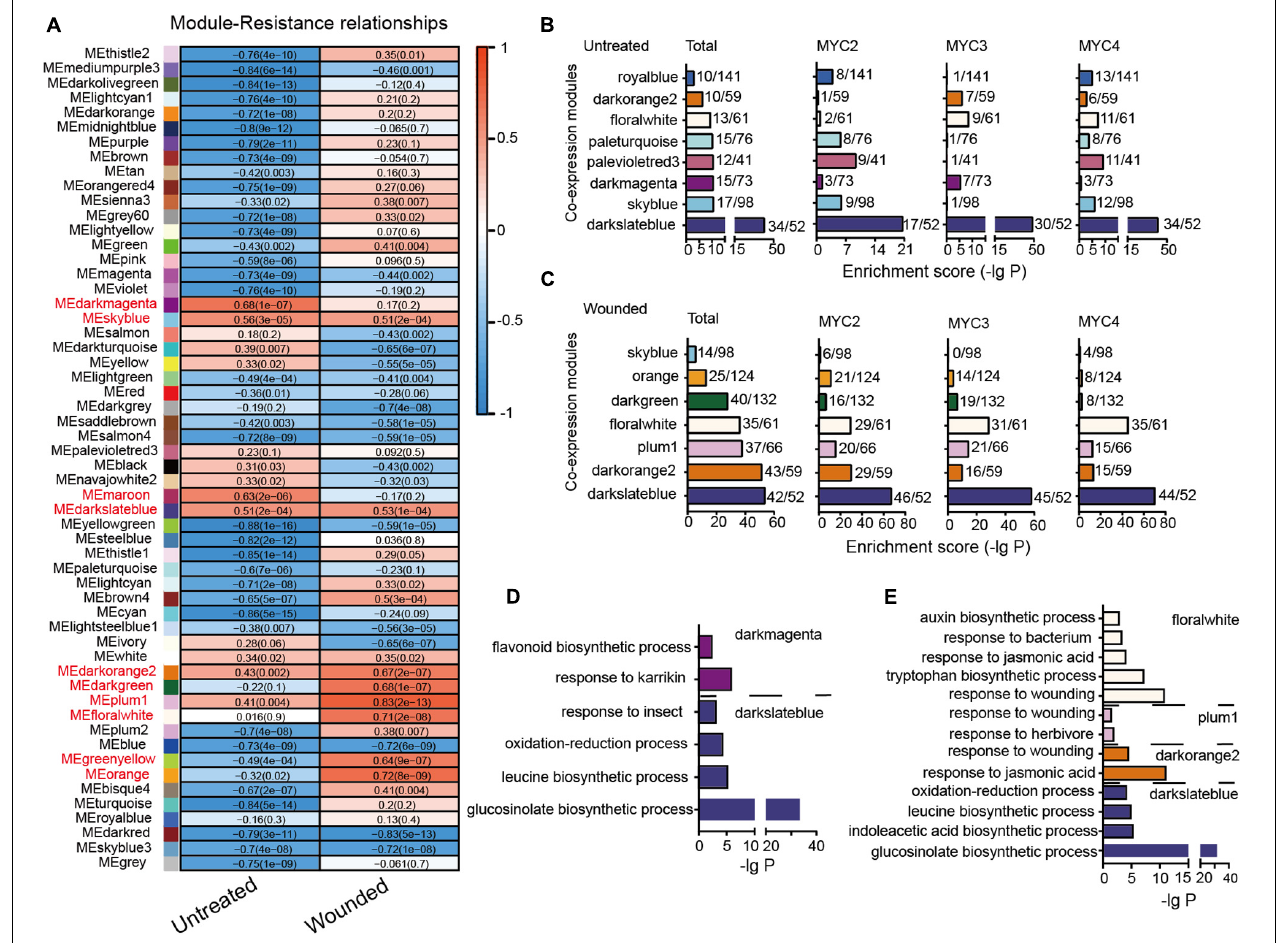
FIGURE 4 | Module classification based on gene co-expression. (A) Correlation of the module eigengenes with cotton bollworm resistance. Red to blue stands for positive to negative correlations between the module eigengenes and the plant resistance to cotton bollworm. The numbers represent correlation coefficients; and the numbers in brackets stand for P -value. (B,C) MYC2-, MYC3-, and MYC4-affected genes of the untreated (B) and wounded (C) plants are enriched in the indicated modules. The a/b values above the bars indicate gene numbers affected by all the three MYCs (Total) or the indicated MYC (a) and gene numbers of the corresponding module (b). (D,E) GO analysis of MYC-affected genes from untreated (D) and wounded (E) plants that were distributed in the indicated